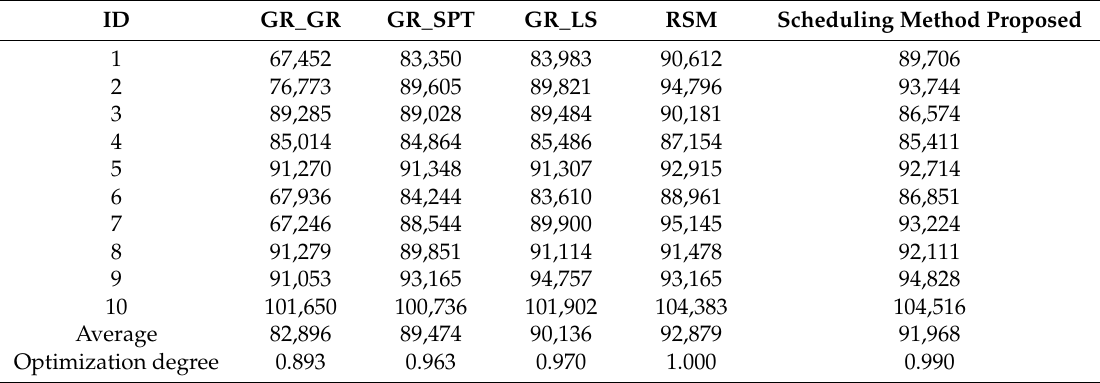
Table 1. Performance indicator “MOV” (in step) under different scheduling methods.